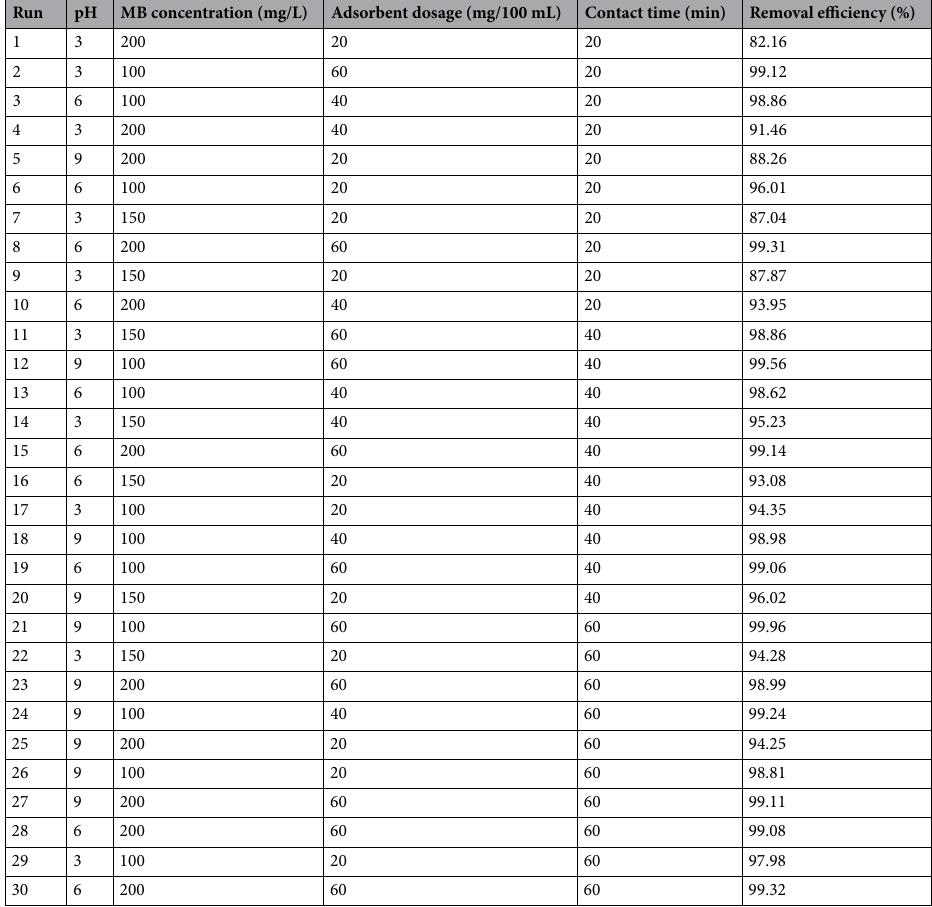
Table 3. Adsorption performance Rumex abysiniccus activated carbon for MB removal.